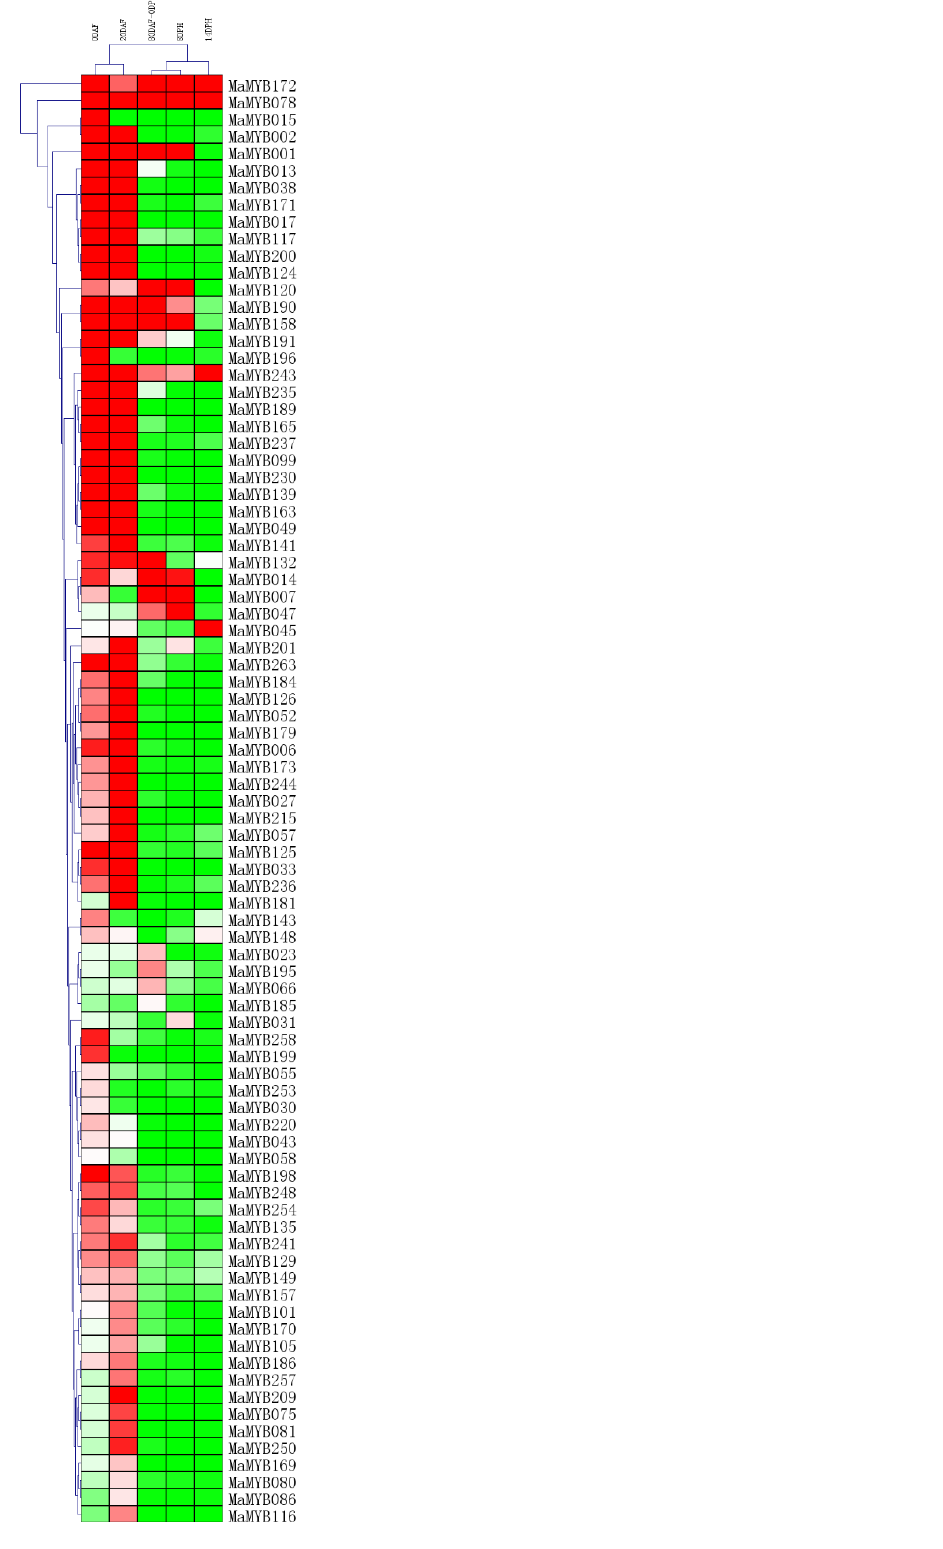
Figure 4. Expression patterns of MaMYBs in different stages of fruit development and ripening. The heatmap with dendrogram was created based on the RPKM values of the MaMYB s . Differences in gene expression changes are shown in color as the scale.